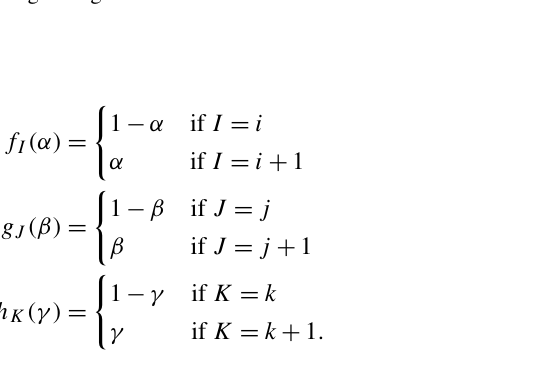
Figure 1. Schematic of the method used for the distribution of the observations on the model grid, represented in two dimensions for simplicity. Panel (a) shows the location of a chosen measurement point in the model’s grid. The steps of the method are (b) to lo- cate the model’s grid points (orange crosses) closest to this loca- tion; (c) to calculate a normalized scalar for each dimension ( α and β ), depending on the distance between the measurement point and the “bottom-left” grid point; (d) to calculate the weight of the four closest grid points. As indicated in the colour scale on the right, this weight ranges between 0 and